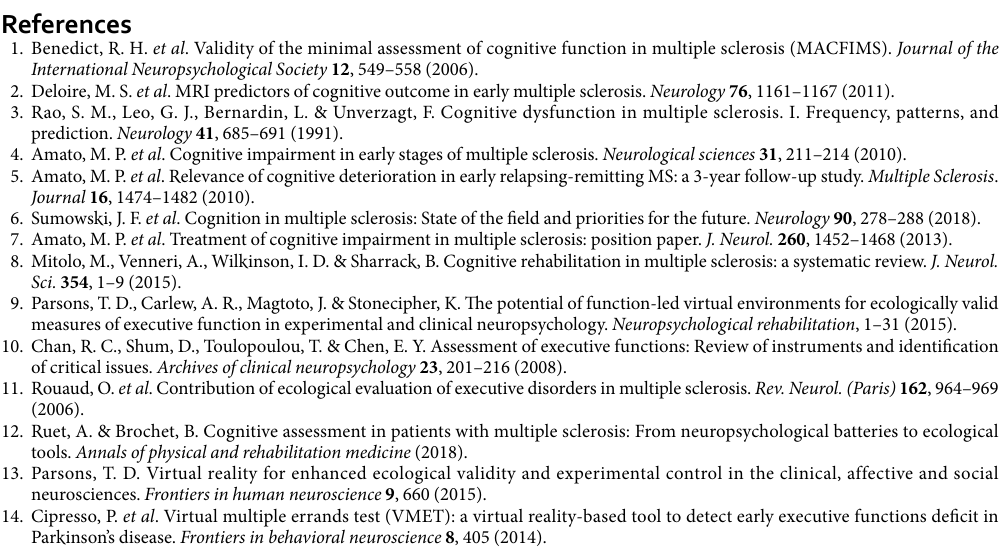
higher-dimensional feature spaces that best separate different features; (d) a naïve Bayes classification. All these analyses were computed using Python 3.4 with the Orange 3.3.5 data mining suite, which was available free in open source code (https://github.com/biolab/orange3).